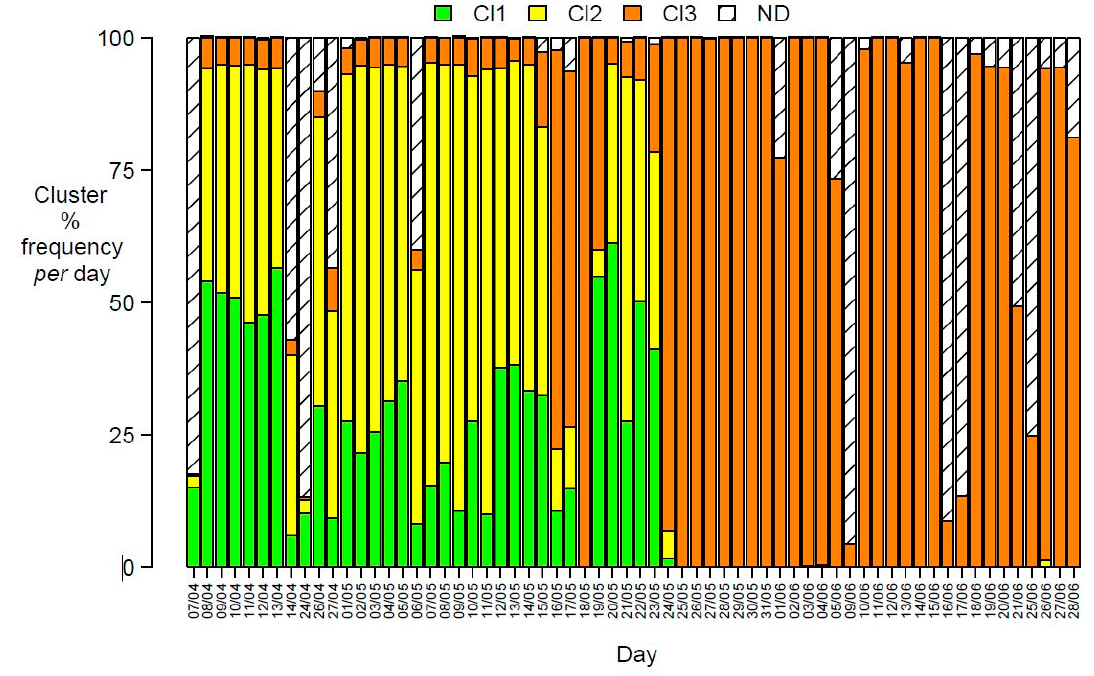
Figure 5. Daily cluster percentage distribution (ND = data not recorded, due to power failures) obtained by the SOM exploratory model for days from 7 April 2017 to 28 June 2017.